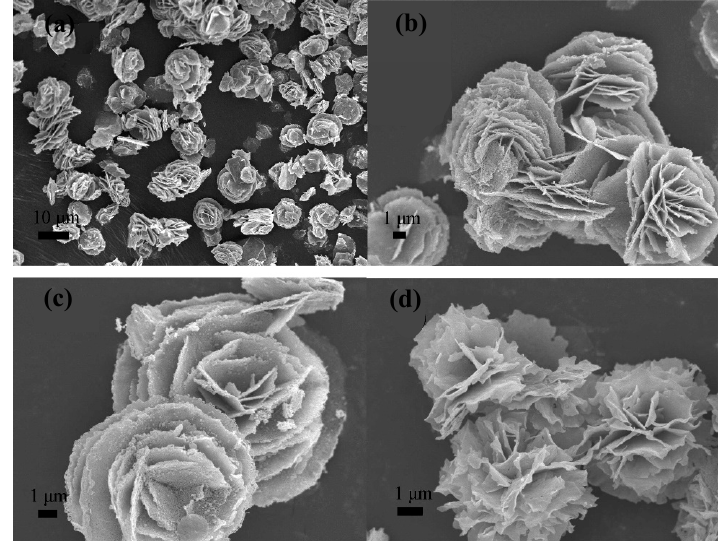
Figure 6. SEM images at low magnification ( a ), and high magnifications ( b , c ) of the Fe 3 O 4 nanoroses obtained after 30 min of reaction; ( d ) the SEM image at low magnification. Reproduced with permission from Reference [127].